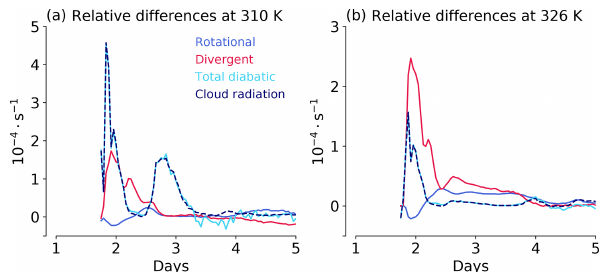
Figure 11. Contribution to the relative growth of difference poten- tial enstrophy from the rotational and divergent flow as well as from total diabatic processes and cloud-radiative heating. Panel (a) is for the 310K isentrope, which is in the lower troposphere. Panel (b) is for the 326K isentrope, which is near the tropopause.